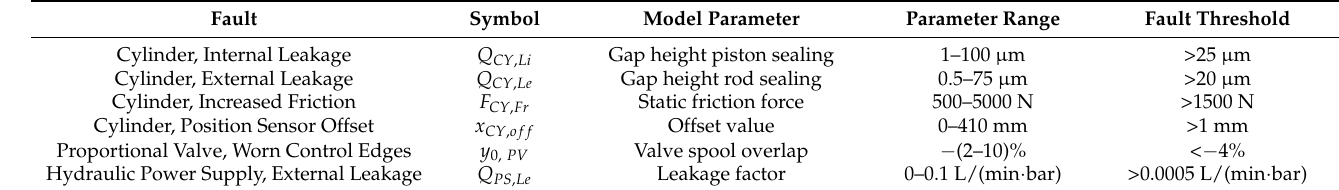
Table 1. Faults of the hydraulic system considered in this study, along with the corresponding model parameters of the simulation model and their ranges of